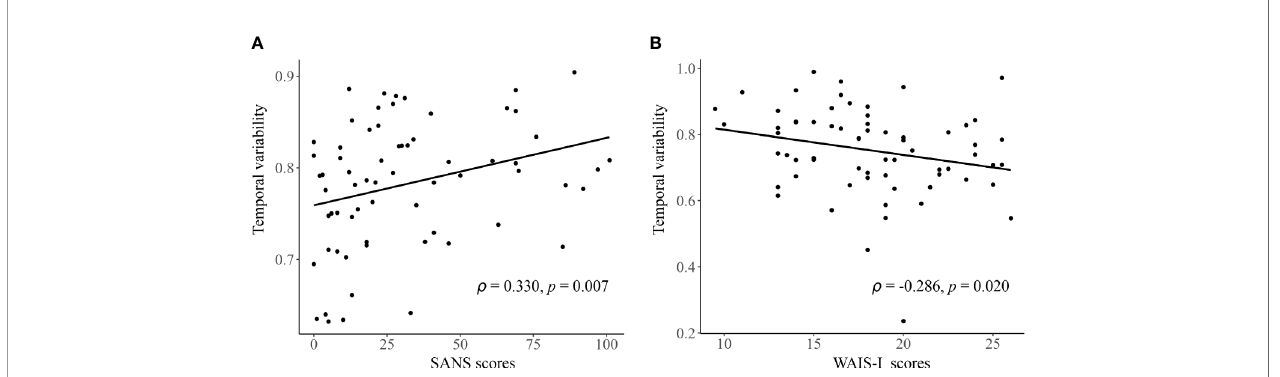
FIGURE 5 | The detected signi fi cant correlations in schizophrenia patients. (A) Correlation between the temporal variability of regional FC for left hippocampus and the SANS scores. (B) Correlation between the temporal variability of inter-network FC between subcortical and auditory networks and the WAIS-I scores. The Spearman ’ s correlation coef fi cients ( r ) and p values are presented on fi gures. FC, functional connectivity; SANS, Scale for Assessment of Negative Symptoms; WAIS-I, Information Subtest of the Wechsler Adult